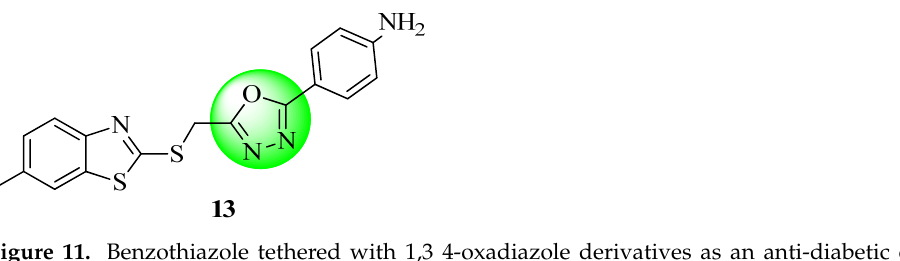
Figure 11. Benzothiazole tethered with 1,3 4-oxadiazole derivatives as an anti-diabetic oxadiazole derivative.